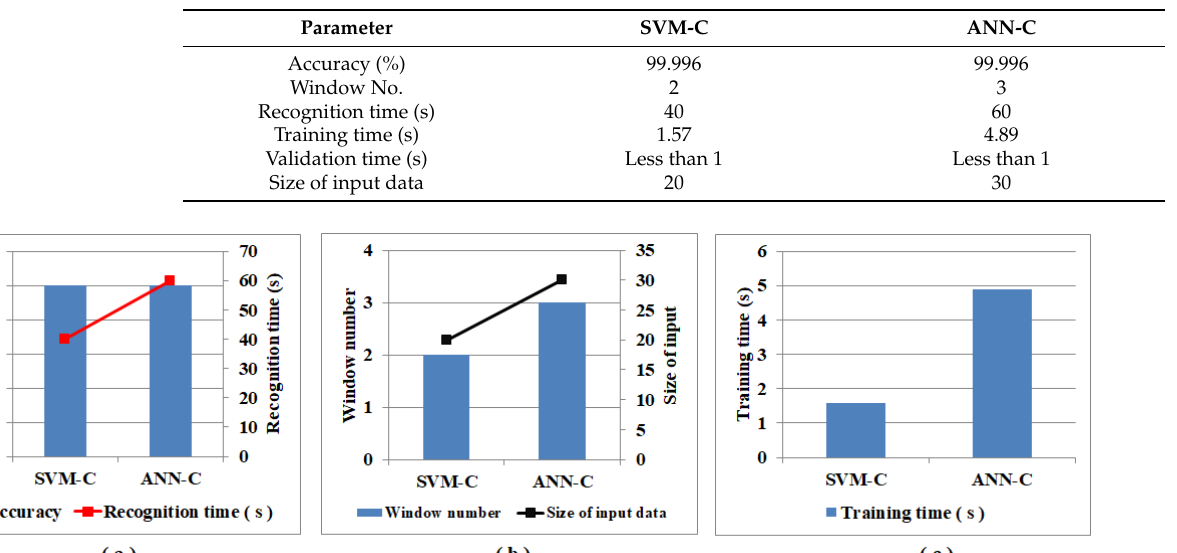
Table 5. Performance comparison of classification models.